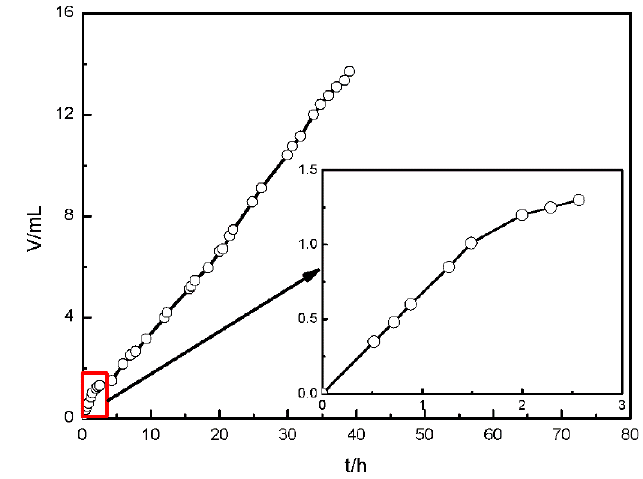
Figure 6. Volume of hydrogen evolution of AZ91D in simulated HA solution.